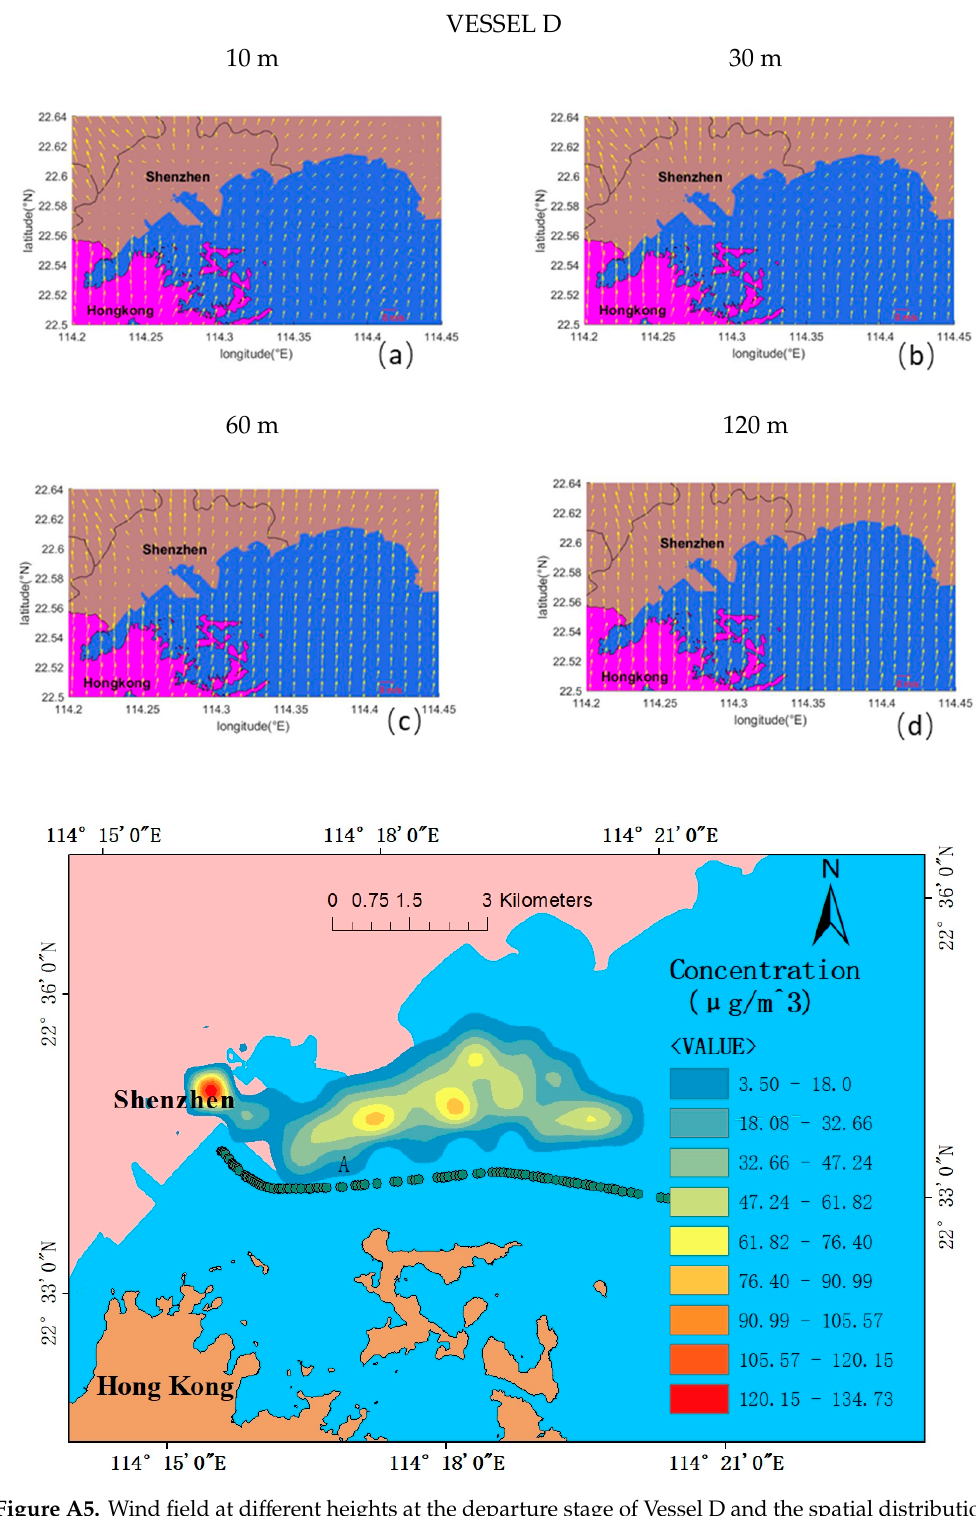
Figure A5. Wind field at different heights at the departure stage of Vessel D and the spatial distribution of the maximum concentration of each simulation grid during the simulation period. ( a ) 10m, ( b ) 30m, ( c ) 60m and ( d ) 120m.